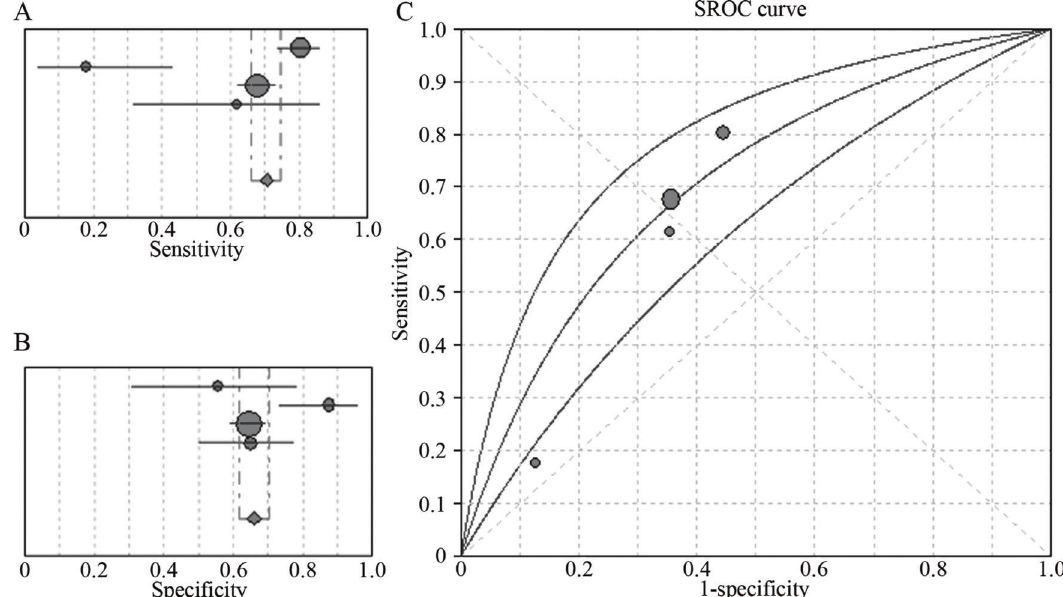
Figure 4 - Four-study analysis of the ability of WLB to diagnose early lung cancer and invasive lung cancer. A. Pooled sensitivity of WLB for the diagnosis of early lung cancer and invasive lung cancer; B. Pooled specificity of WLB for the diagnosis of early lung cancer and invasive lung cancer; C. The SROC curve for the diagnosis of early lung cancer and invasive lung cancer by